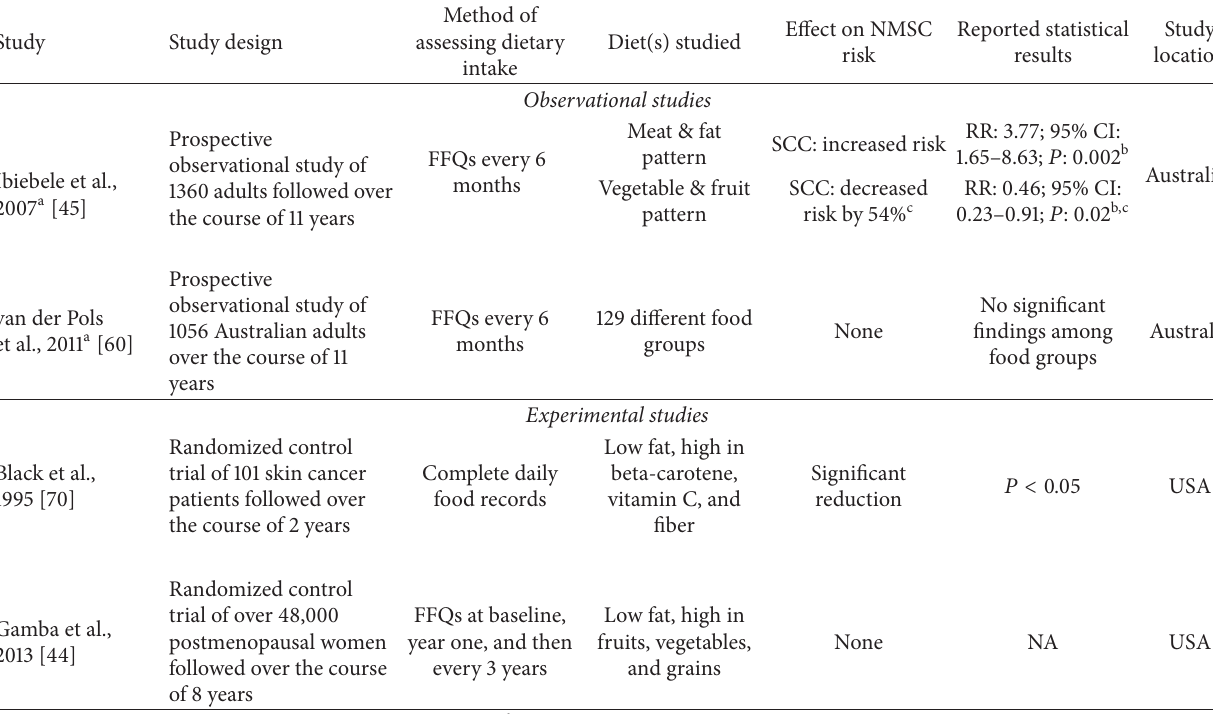
Table 4: AO intake via whole foods and NMSC